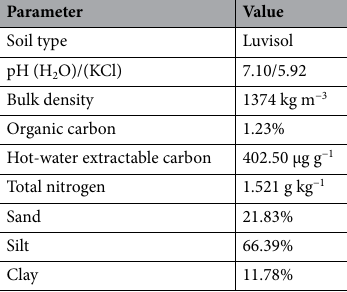
Table 2. Parameters of soil used in the analysis of herbicide laboratory